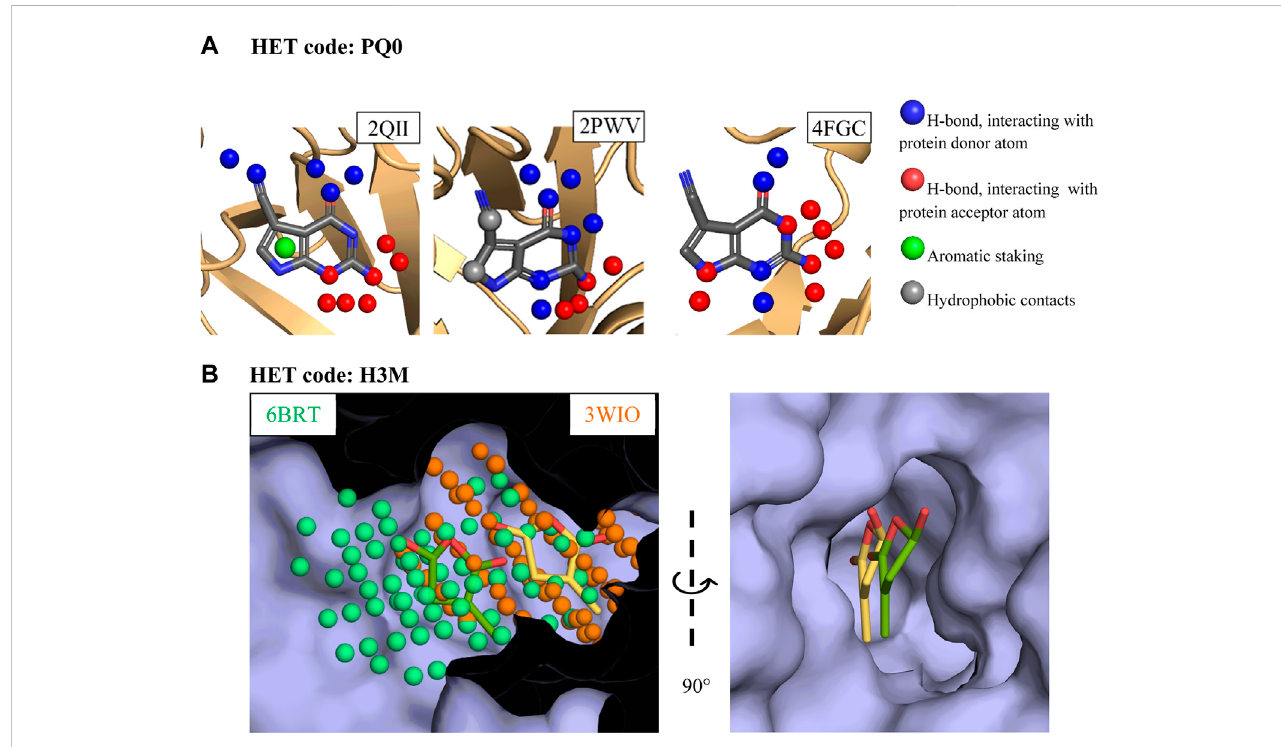
FIGURE 3 Examples ofthree-dimensionalstructures ofPDBversatile fragments (A) Interactionsformedby pyrrolo-pyrimidine intRNA-guanine transglycolaseand nitryl reductase QueF. (B) Substituted furanone binding to two adjacent subpockets in strigolactone esterase D14. The cavity points representing the two subpockets and used for the comparison of the two sites are shown in the left